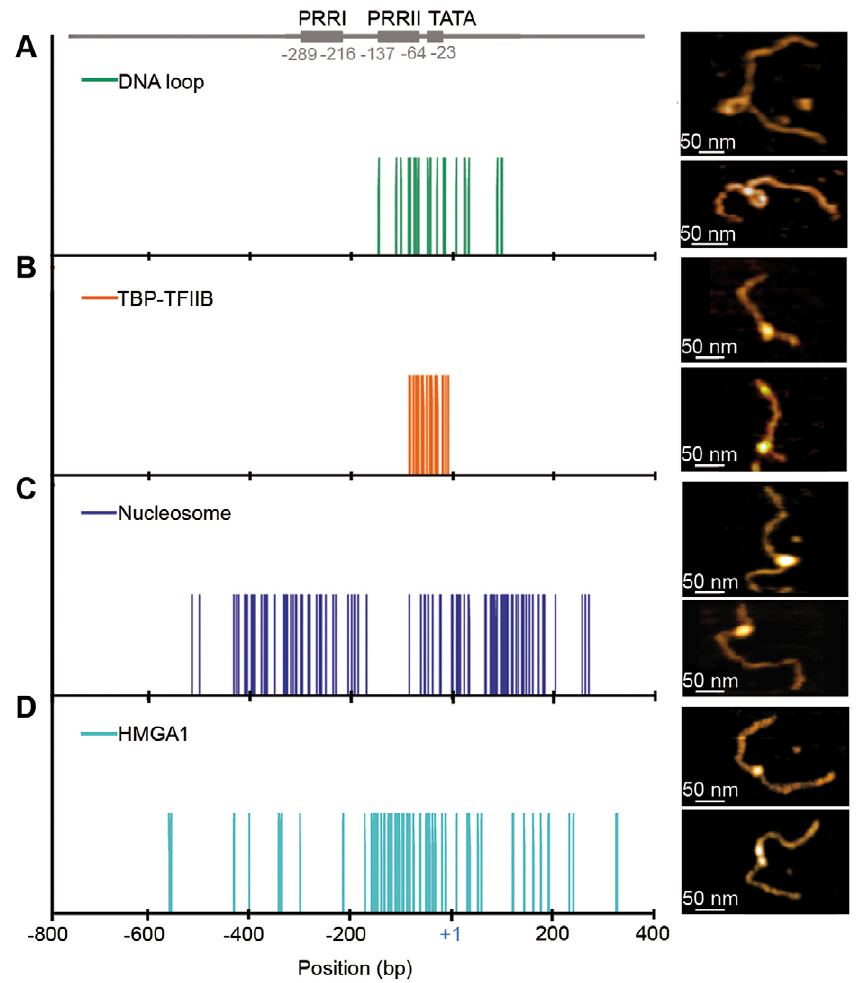
Figure 3. AFM imaging of DNA loop, GTF, nucleosome and HMGA1 positioning on the IL2RA gene promoter. (A) AFM imaging in liquid of DNA loop positioning along the 1290 bp IL2RA fragment (upper right panel) and the 898 bp IL2RA fragment (lower right panel) and statistical analysis (left panel) of their positioning given by the loop middle point (green vertical bars) from N=21 AFM images. (B) AFM imaging of TBP-TFIIB positioning along the 563 bp IL2RA fragment (right panels) and statistical analysis (left panel) of their positioning (orange vertical bars) from N=51 AFM images. (C) AFM imaging of mononucleosome positioning along the 898 bp IL2RA fragment (right panels) and statistical analysis (left panel) of dyad positioning (blue vertical bars) from N=100 AFM images. (D) AFM imaging of HMGA1 positioning along the 898 bp IL2RA fragment (right panels) and statistical analysis (left panel) of dyad positioning (blue vertical bars) from N=73 molecules.